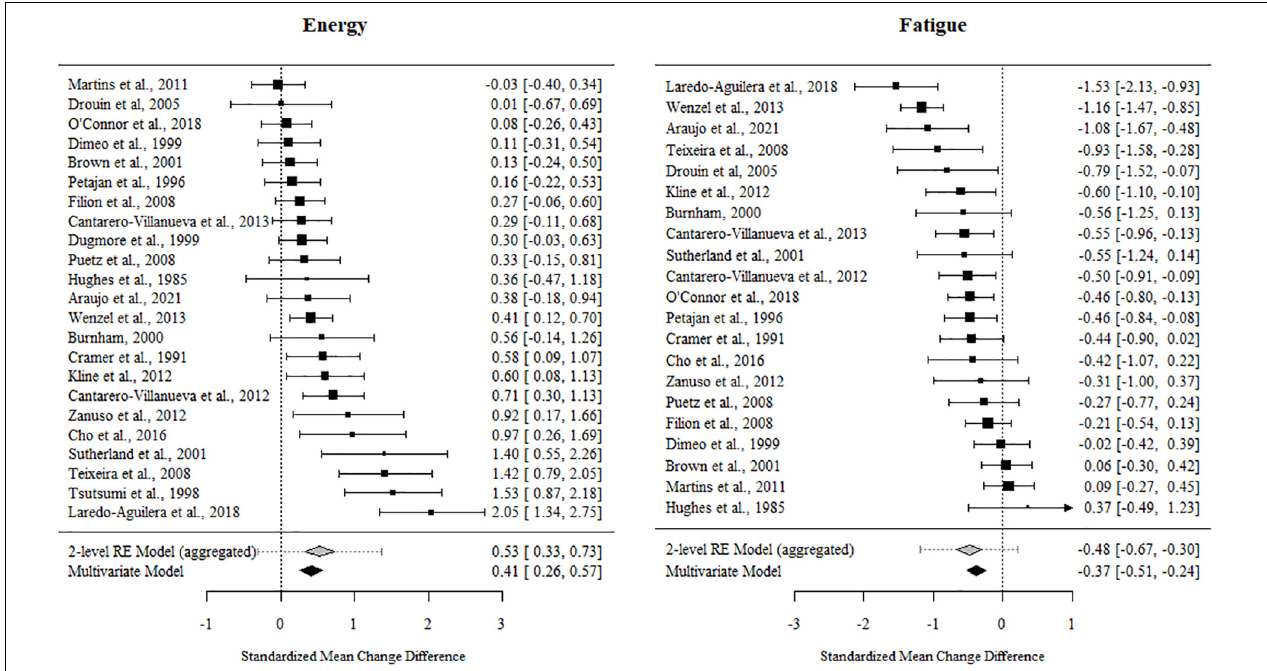
FIGURE 4 | Forest plots for energy and fatigue. Aggregated study effects displayed with a mean estimate coming from a meta-analytic model and a two-level random effects model for comparison